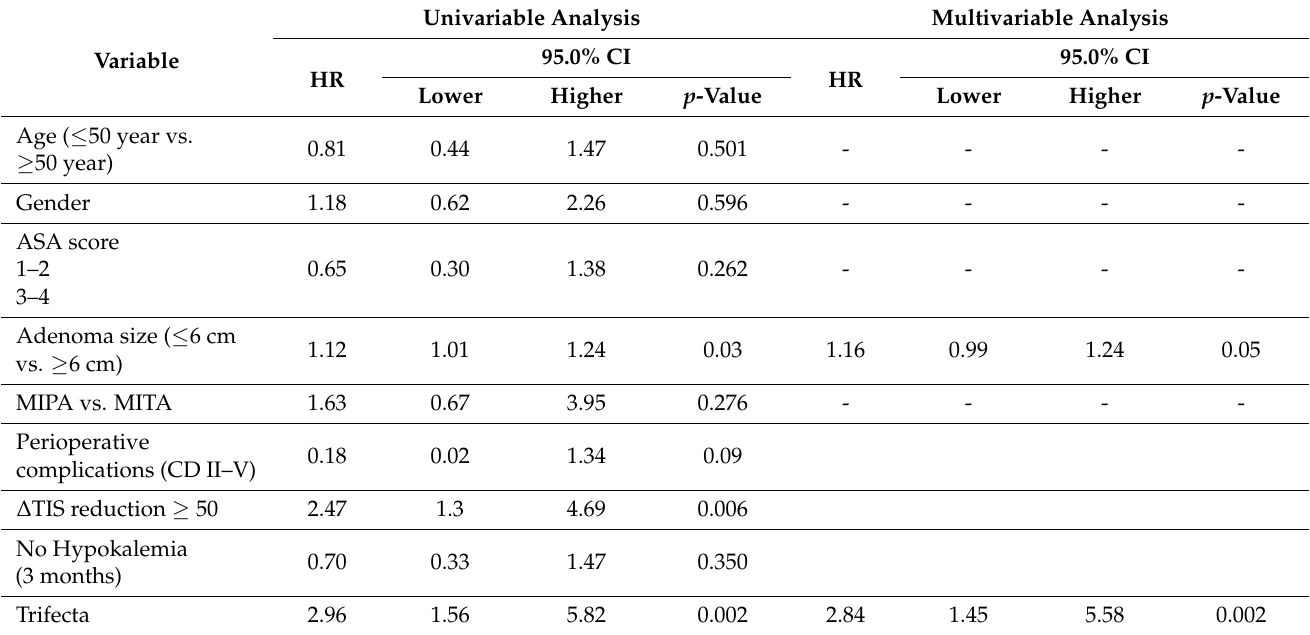
Table 7. Univariable and multivariable logistic regression analysis to identify predictors of complete clinical success according to PASO criteria.